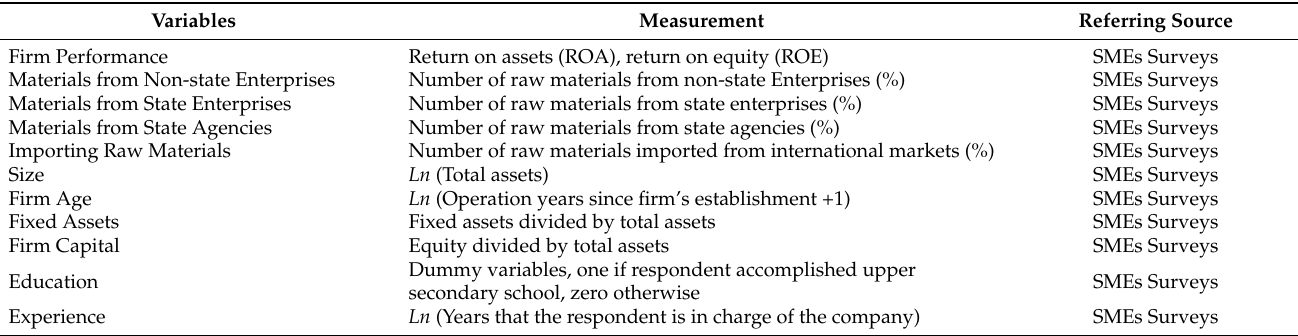
Table 2. Proposed